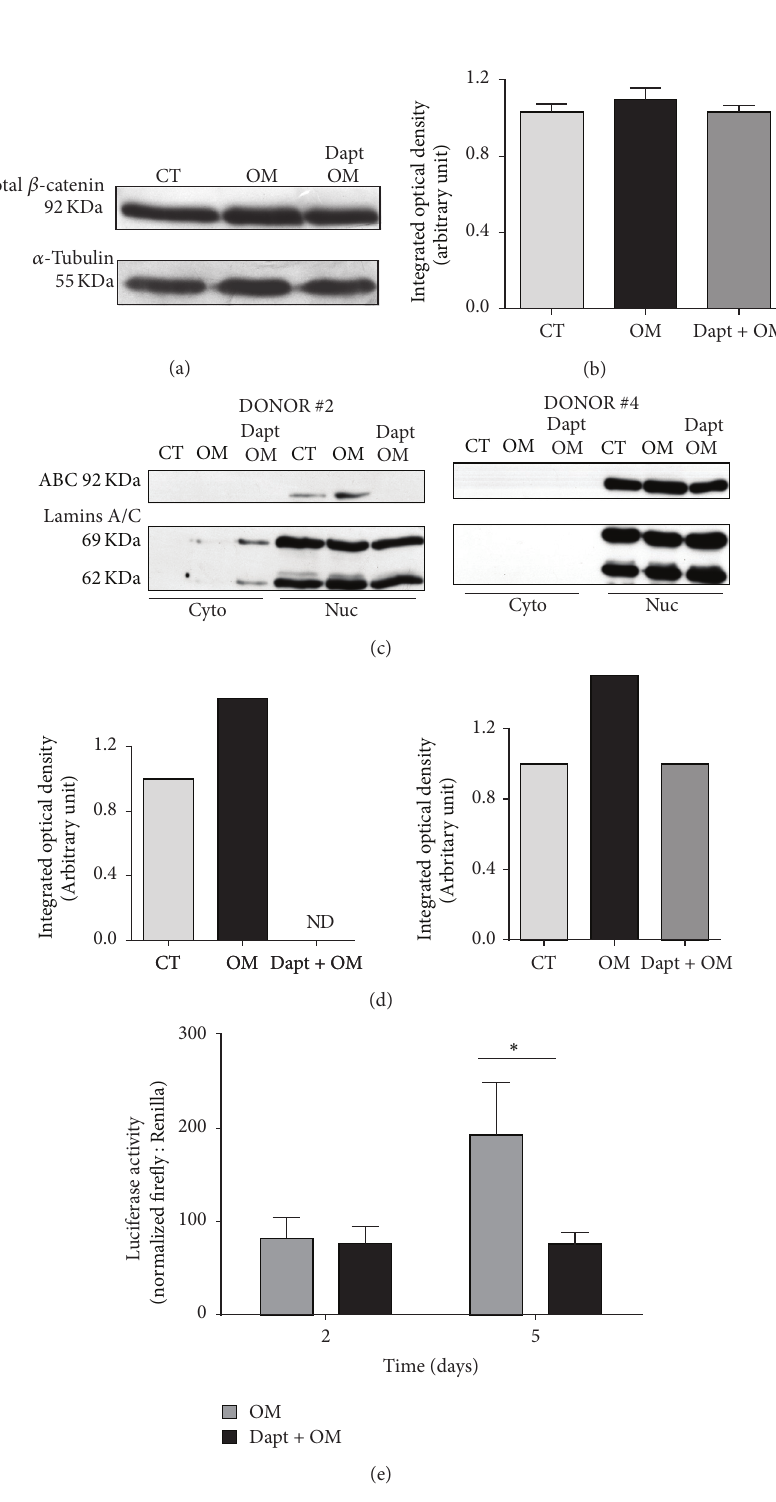
Figure 5: PS1/ 𝛾 -secretase inhibition impairs 𝛽 -catenin nuclear translocation and signaling. (a) Representative immunoblotting of total 𝛽 - catenin in whole protein extracts. (b) Densitometry of total 𝛽 -catenin bands obtained in 5 independent experiments. Data represent mean ± SD. (c) Representative immnunoblotting of the active form of 𝛽 -catenin (ABC) in cytoplasmic and nuclear cell fractions from two different donors.(d)DensitometryofABCnuclearbandsnormalizedbylaminA.(e)LuciferaseactivityinBMSCscontainingaSuperTopTCFreporter, osteoinduced for 2 and 5 days in the presence of Dapt. Bars represent mean ± SD of 5 different donors performed in triplicate. CT = control undifferentiated cells; OM = osteogenic medium; Dapt + OM = osteogenic medium with Dapt. ∗ 𝑝 < 0.05